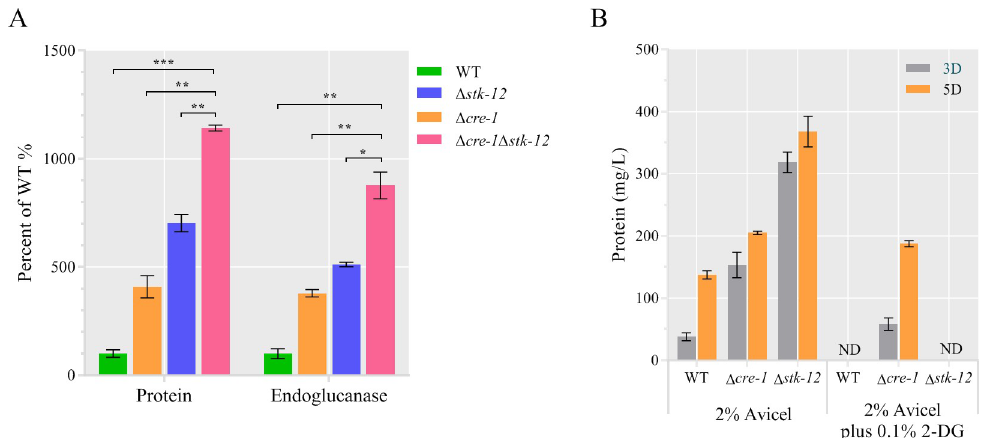
Fig 11. Enhanced cellulase production in the Δ stk-12 mutant does not result from relief from catabolite repression mediated by cre-1 . (A) Conidia from Δ cre-1 Δ stk-12 , Δ cre-1 , Δ stk-12 , and wild-type (WT) strains were separately inoculated into Avicel medium and batch-cultured for 3 days. Total extracellular protein concentration and endoglucanase activity of culture broth are expressed as percentages of those in WT. Values are means of at least three biological replicates, error bars show standard deviation. Statistical significance was determined by two-tailed Student’s t -test ( � , P < 0.05; �� , P < 0.01; ��� , P < 0.001). (B) Cellulase production in Avicel medium with or without 0.1% 2-deoxy-glucose (2-DG). Total extracellular protein concentration was measured after 5 days of culture. Values are means of at least three biological replicates, error bars show standard deviation. ND, not